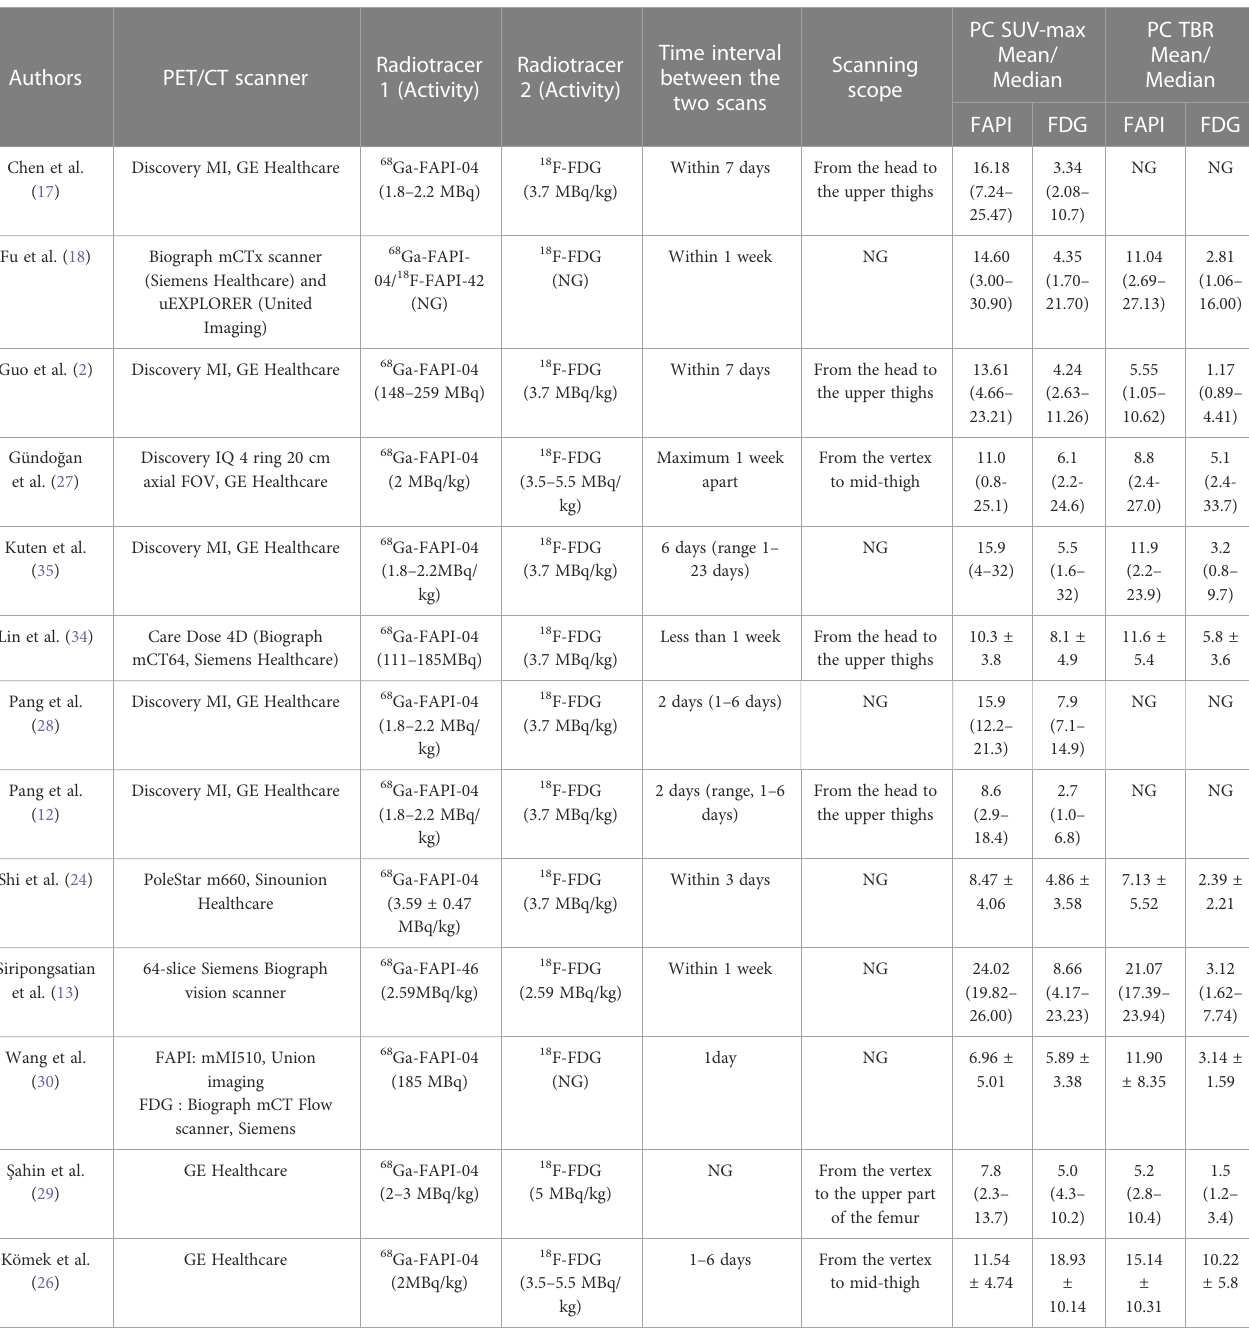
FAPI, fi broblast activation protein inhibitor; FDG, fl uorodeoxyglucose; NG, Not given; PC, primary tumour; SUV-max, maximum standardized uptake value; TBR, tumor-to-background ratio; GE, General Electric